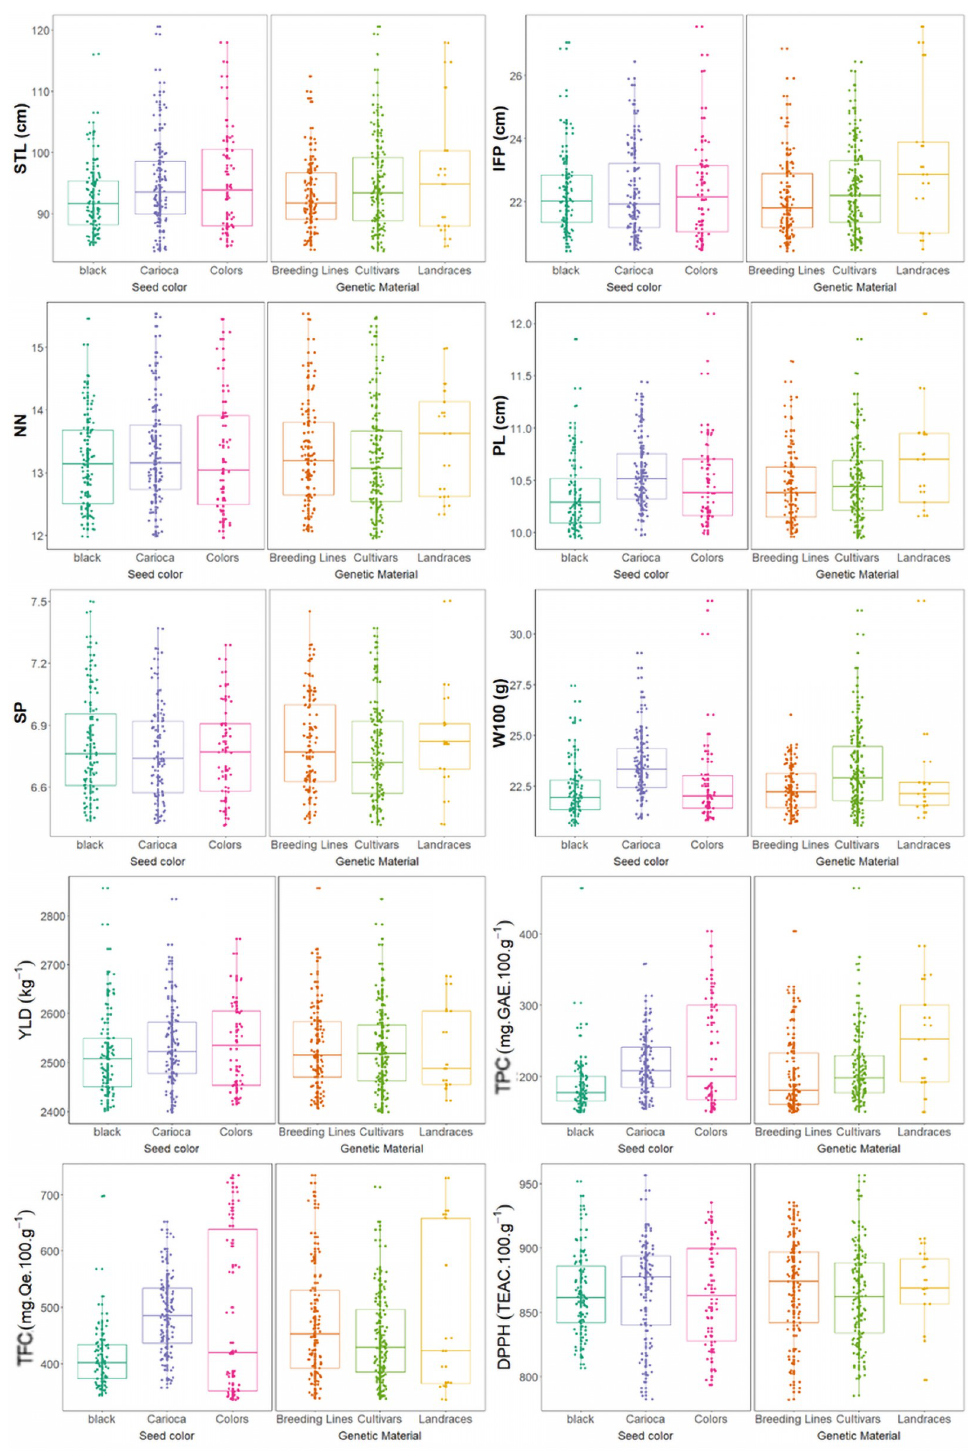
Fig 3. Morpho-agronomic and biochemical traits of 215 Mesoamerican common bean accessions. Box plots are based on BLUP values. STL: Main stem length, IFP: Insertion height of the first pod, NN: Number of nodes on main stem, PL: Pod length, SP: Number of seeds per pod, W100: Weight of 100 seeds, YLD: Seed yield, TPC: Total phenolic contents, TFC: Total flavonoid contents, and DPPH: Antioxidant capacity.